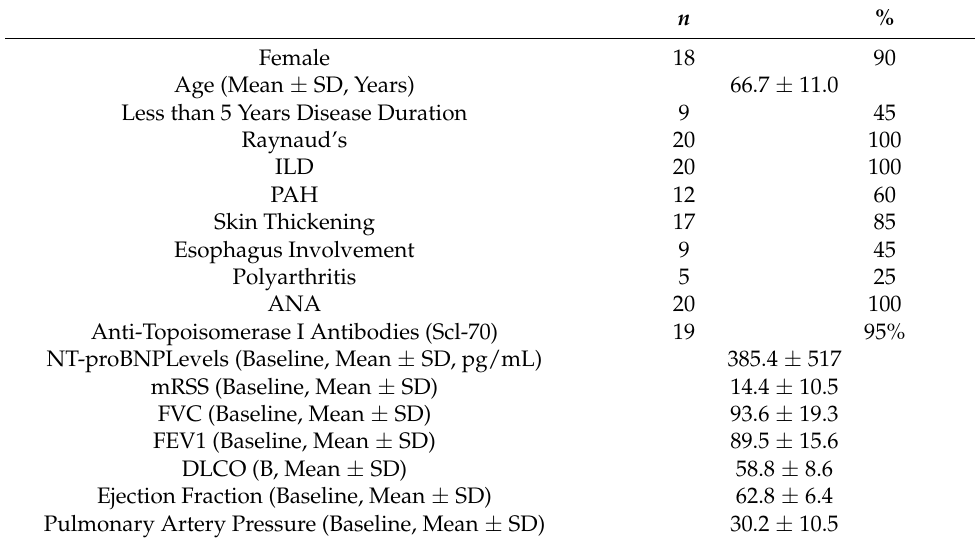
Table 1. Baseline characteristics.